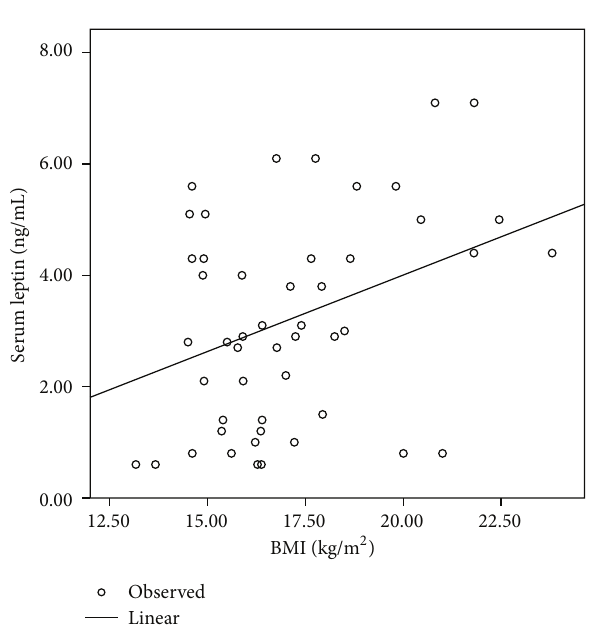
Figure 1: Correlation between serum leptin levels (ng/mL) and BMI (kg/m 2 )in 𝛽 -TMpatients.Pearsoncorrelationcoefficient( 𝑟 = 0.353 , 𝑃 = 0.012